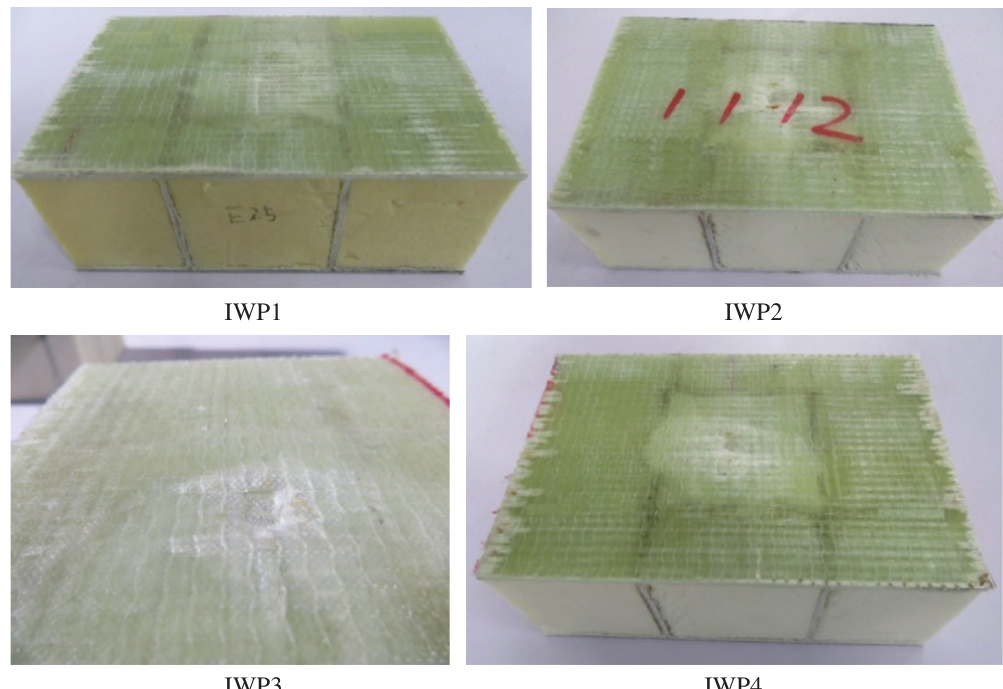
Figure 14: Damage of specimens under